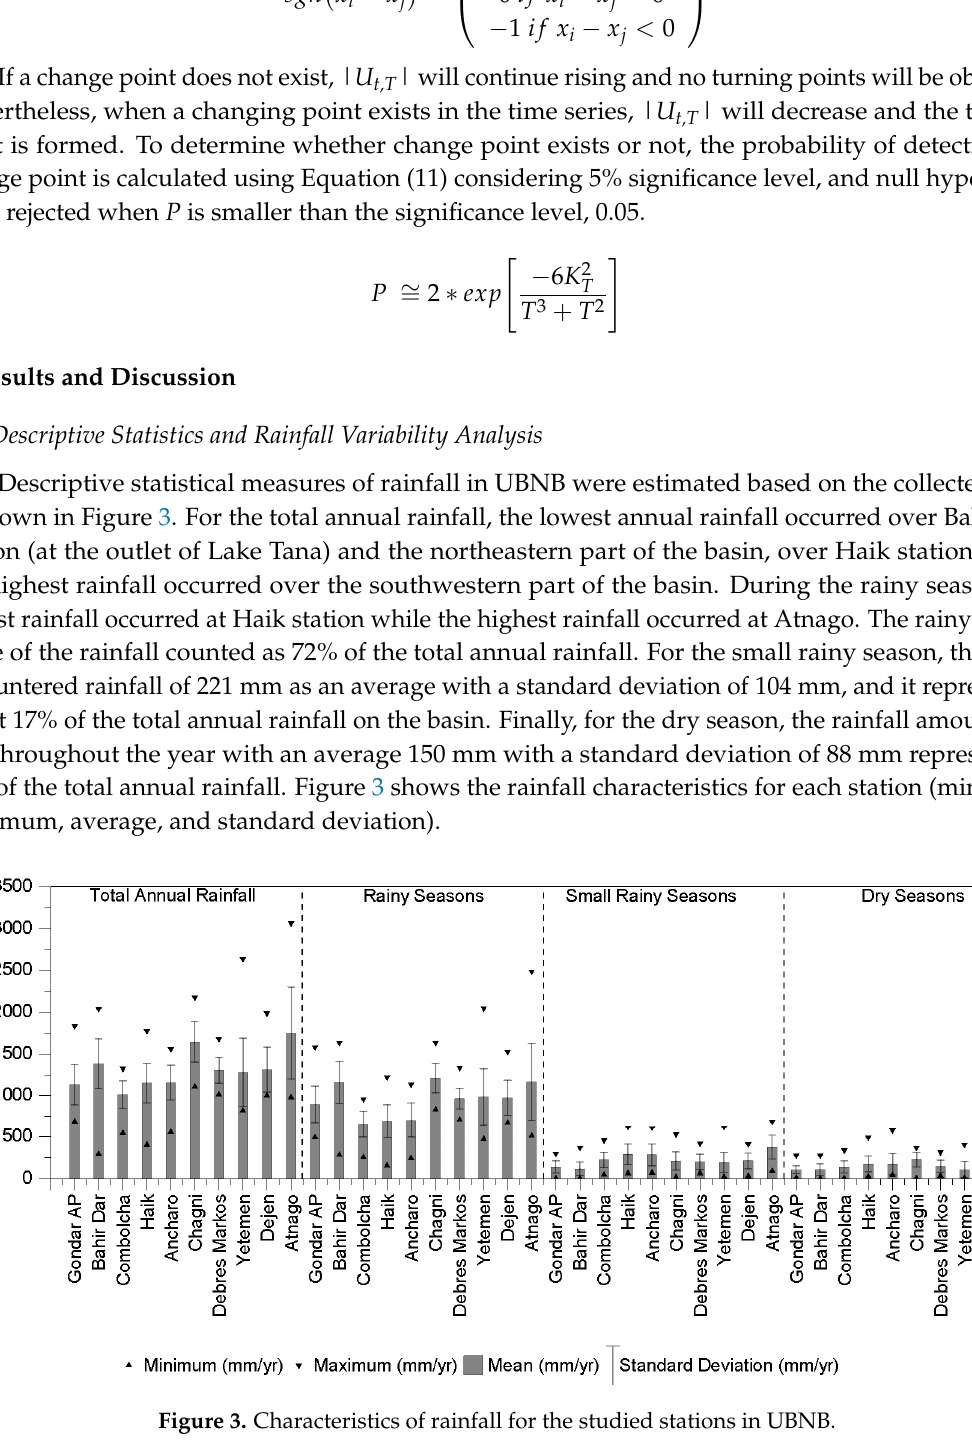
Figure 3. Characteristics of rainfall for the studied stations in UBNB.